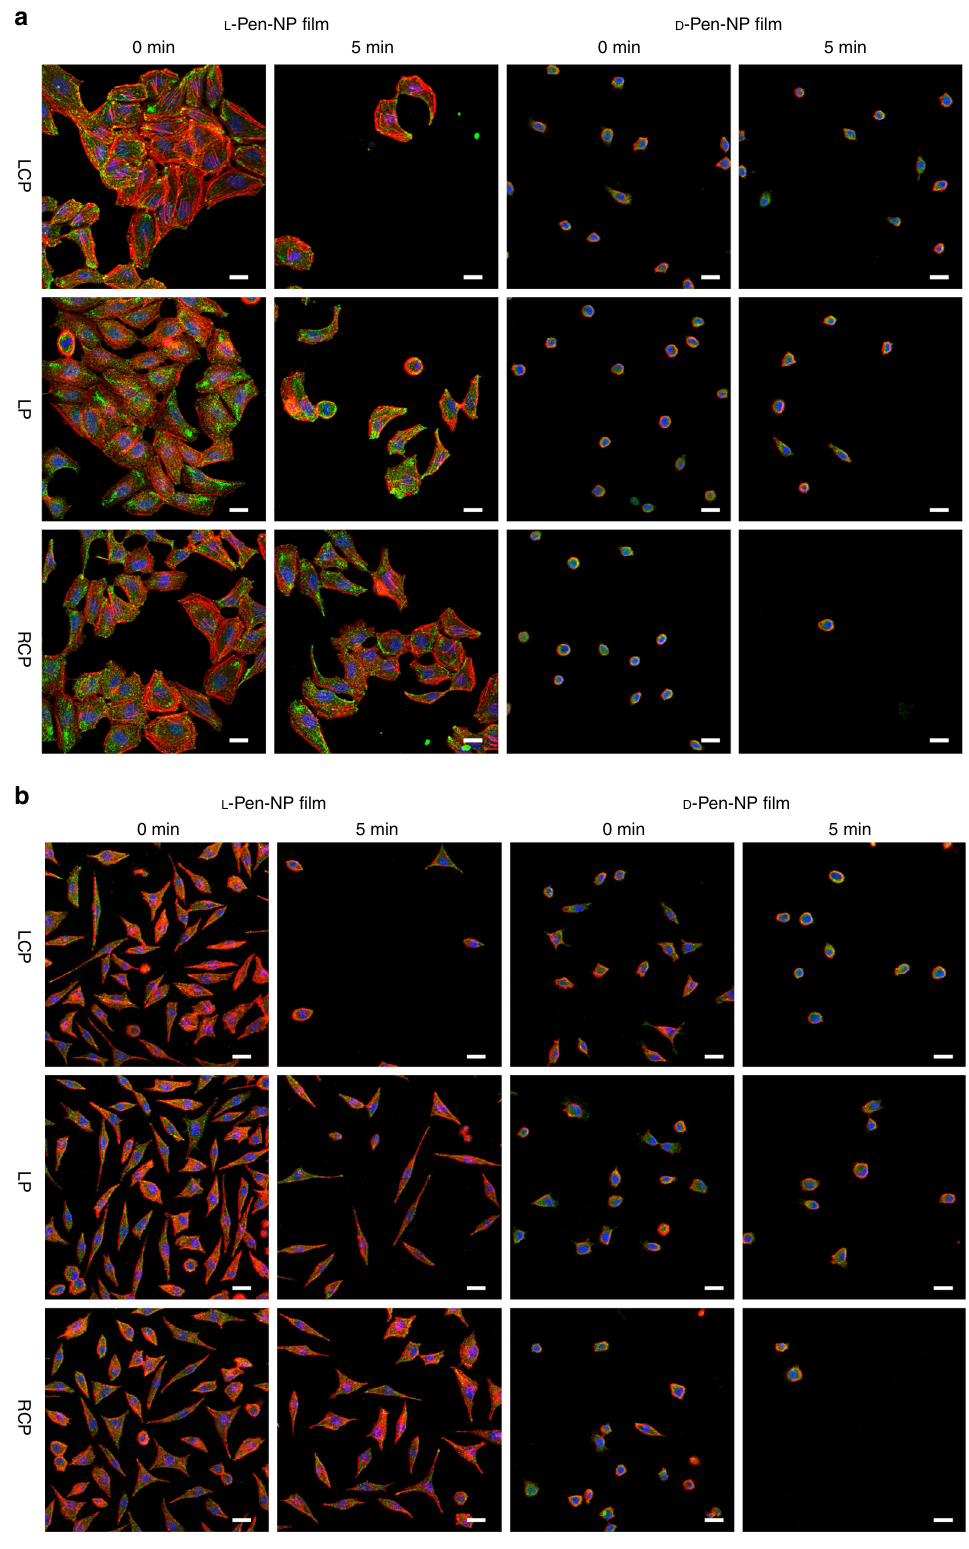
Fig. 6 Circularly polarized light triggered HeLa and PCS-460-010 cells detachment. Confocal images of ( a ) HeLa cell and ( b ) PCS-460-010 cell grown on L / D -Pen-NP fi lm upon circular polarized light irradiation (808 nm laser, 150 mW/cm 2 ). Scale bar, 25 μ